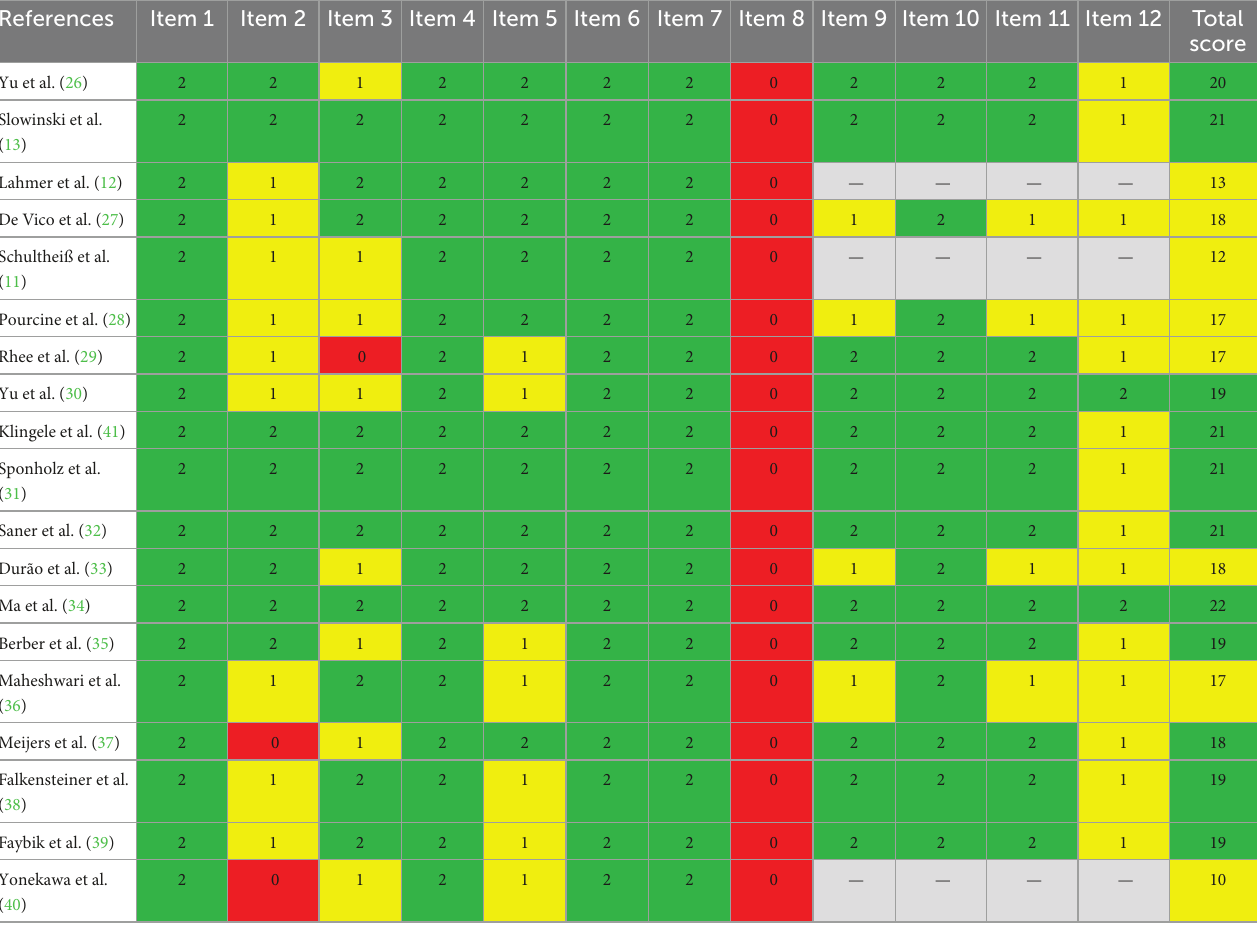
TABLE 2 Risk of bias in each study assessed using the MINORS